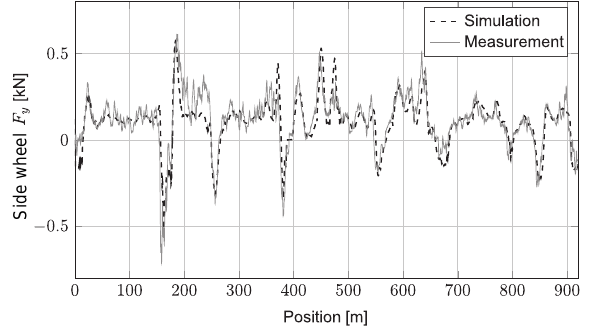
Figure 13. Tangential force F y on a side wheel: measurement and simulation.